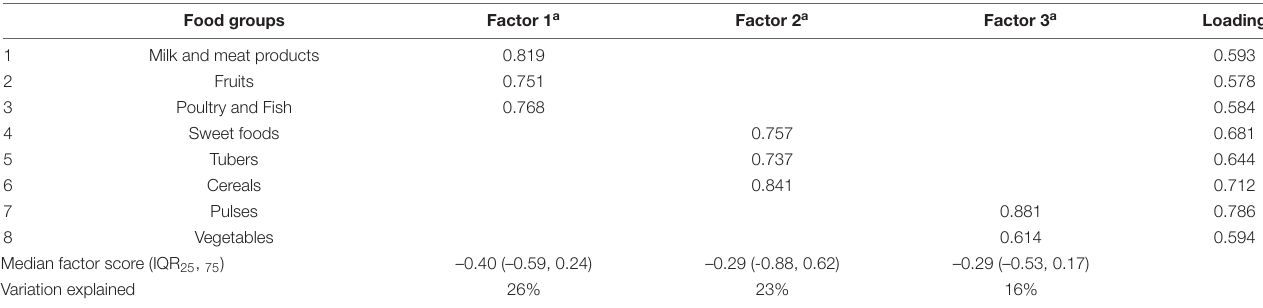
TABLE 1 | Summary table for factor loading, factor scores, and variance explained by the major dietary patterns for each food groups among pregnant women in Eastern